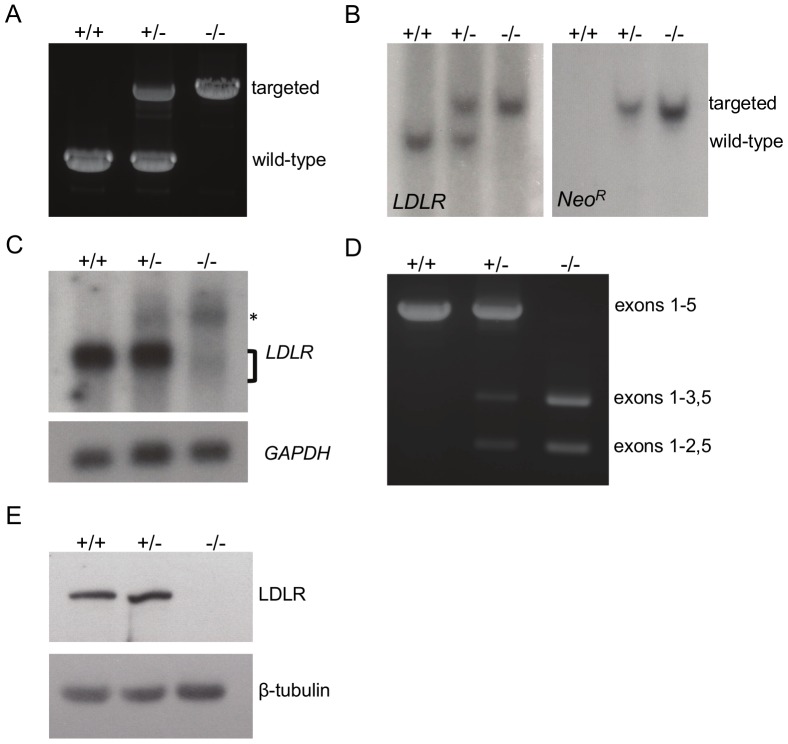
Molecular and biochemical characterization of LDLR+/+, LDLR+/−, and LDLR−/− pigs.A. Genotyping by PCR. Expected sizes are 1.5-type LDLR and 3.2 kb for targeted LDLR. B. Southern blot of genomic DNA. (Left) XmnI digested genomic DNA was hybridized with a probe that detects porcine LDLR downstream of the targeting vector boundary. The LDLR-targeted allele produced an approximately 7.8 kb band, and the wild-type band is approximately 6.0 kb. (Right) The same DNA was hybridized with a probe that detects the NeoR cassette, yielding only the targeted 7.8 kb band. C. Northern blot of LDLR and GAPDH mRNA. Full-length LDLR and GAPDH mRNAs are 5.1 and 1.5 kb, respectively. The asterisk represents a minor mRNA species consisting of full-length LDLR mRNA plus the NeoR cassette. The bracket indicates two minor mRNA species that are likely the result of nonsense-mediated mRNA altered splicing. D. Representative RT-PCR. Using PCR primers that amplify from exon 1 to exon 5, the targeted LDLR allele produces no normal mRNA, but does produce mRNA species with deletions of exon 4 or exons 3 and 4. This is seen in both the LDLR+/− and LDLR−/− pigs. This result was confirmed by DNA sequencing. E. Representative western blot of LDLR and β-tubulin. LDLR is ∼150 kDa and β-tubulin is 51 kDa.